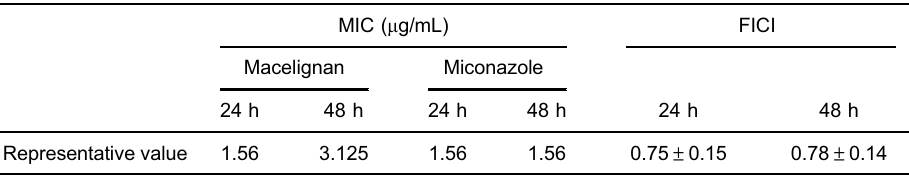
Table 6. Synergistic antifungal effects of macelignan combined with miconazole against A. apis indicated by minimum inhibitory concentration (MIC) and fractional inhibitory concentration index (FICI). MIC ( m g/mL)